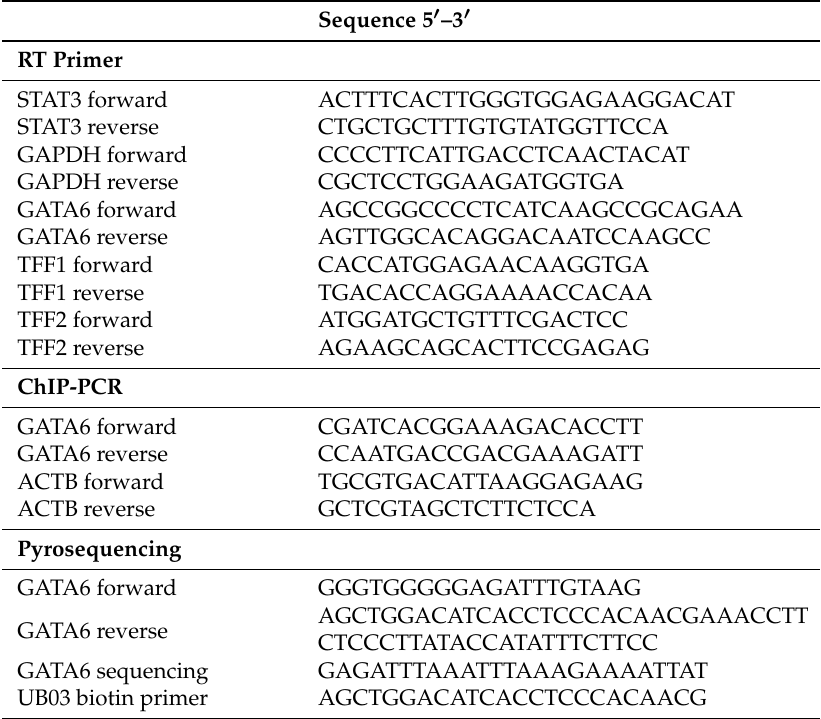
Table 3. Primer sequences used in this